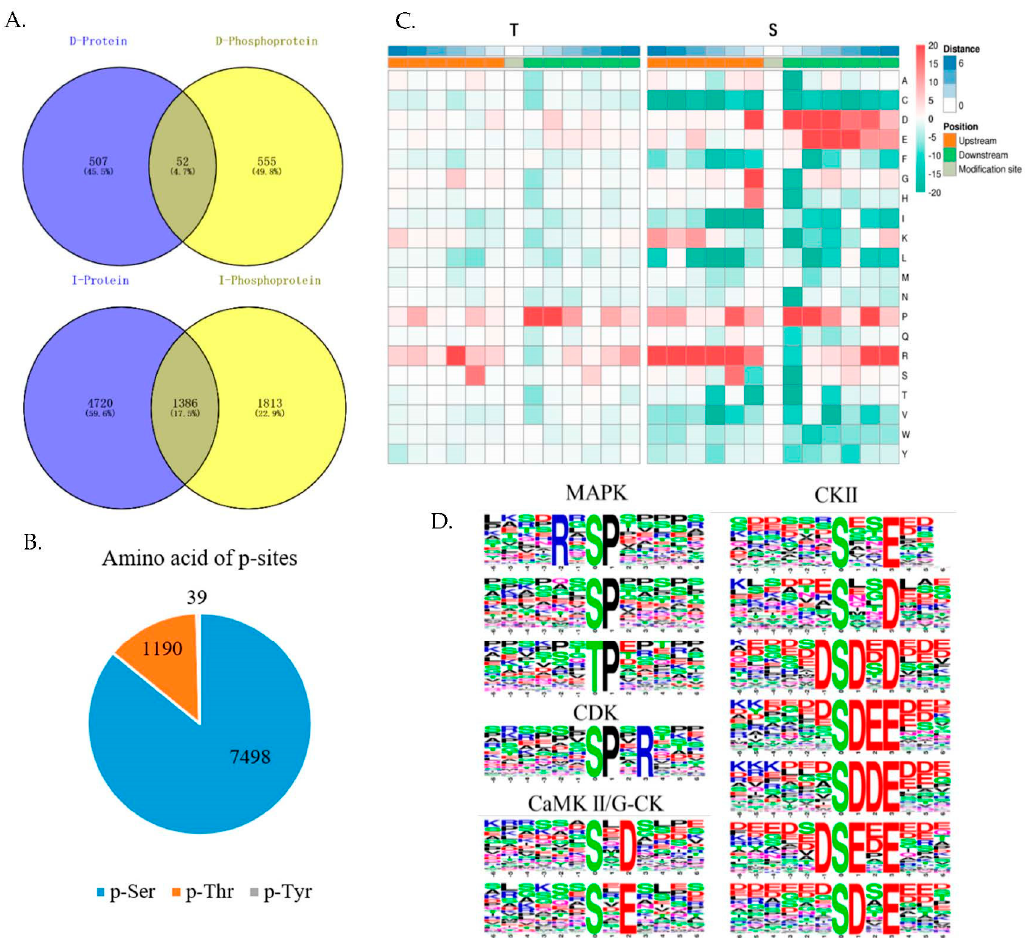
Figure 3. The overlaps of the proteomic and phosphoproteomic data and motif analysis of the identified phosphosites. ( A ) The overlap of di ff erentially expressed proteins and phosphoproteins (top) and overlap of identified proteins and phosphoproteins (bottom). ( B ) Distribution of the number of di ff erent amino acid modification sites identified. ( C ) The motif enrichment heatmap of up-stream and down-stream amino acids of all identified modification sites. Red indicates that the amino acid is significantly enriched near the modification site and green significantly reduced near the modification site. ( D ) Significantly enriched phosphorylation motifs (CKII, MAPK, CDK, CaMK II / G-CK) of elovl6 − / − zebrafish vs. wild type zebrafish. D-Protein / Phosphoprotein, di ff erentially expressed proteins / phosphoproteins; I- Protein / Phosphoprotein, identified proteins / phosphoproteins; CaMK II, calcium / calmodulin kinase II; CDK, cyclin-dependent kinase; CKII, casein kinase II; elovl6 , elongation of very long-chain fatty acids family member 6; G-CK, Golgi casein kinase; MAPK, mitogen-activated protein kinase.